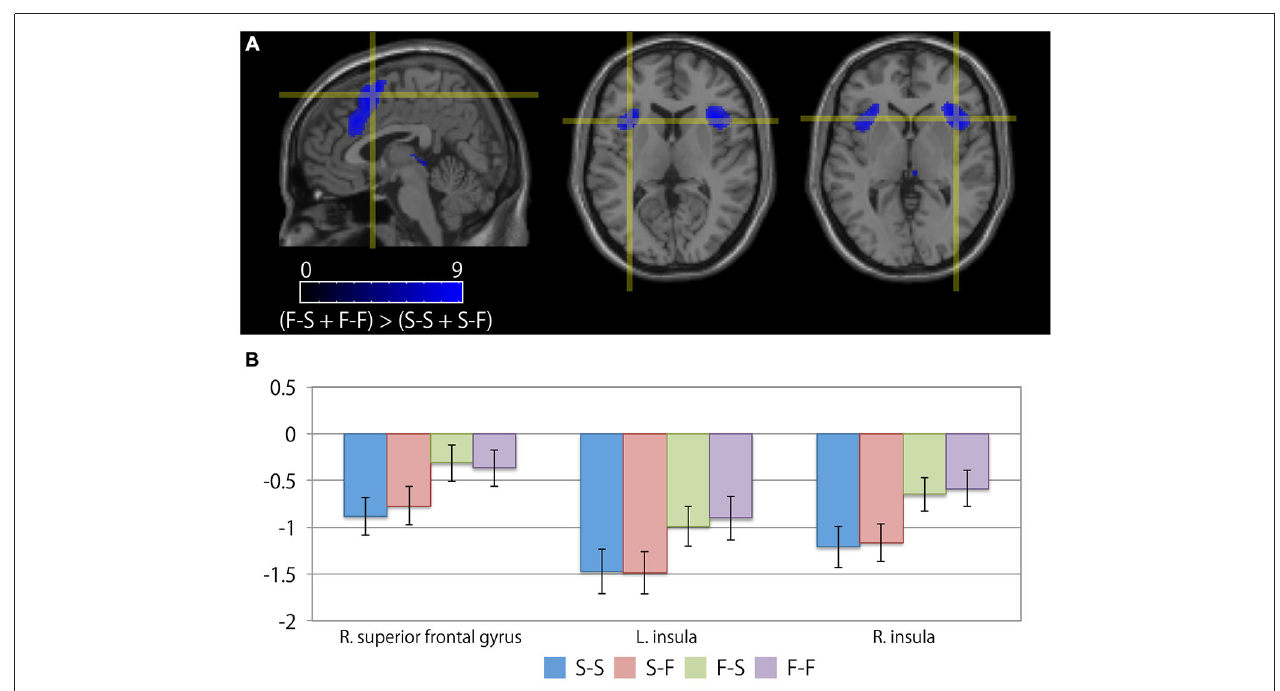
FIGURE 4 | Cortical regions exhibiting differences between the receipt of negative feedback indicating an error and the receipt of positive feedback. (A) The crosshair icon marks the location of the activation peaks in the right superior frontal gyrus (left; sagittal slice: x = 4 mm), and the bilateral anterior insular regions (center; coronal slice: y = 16 mm, and right; coronal slice: y = 18 mm) on the MNI single subject template. The color scale indicates the t -values for the activation clusters. (B) Bar chart illustrating the percent signal changes within an activation cluster for each condition calculated using MarsBar toolbox. The error bars represent the standard error of the